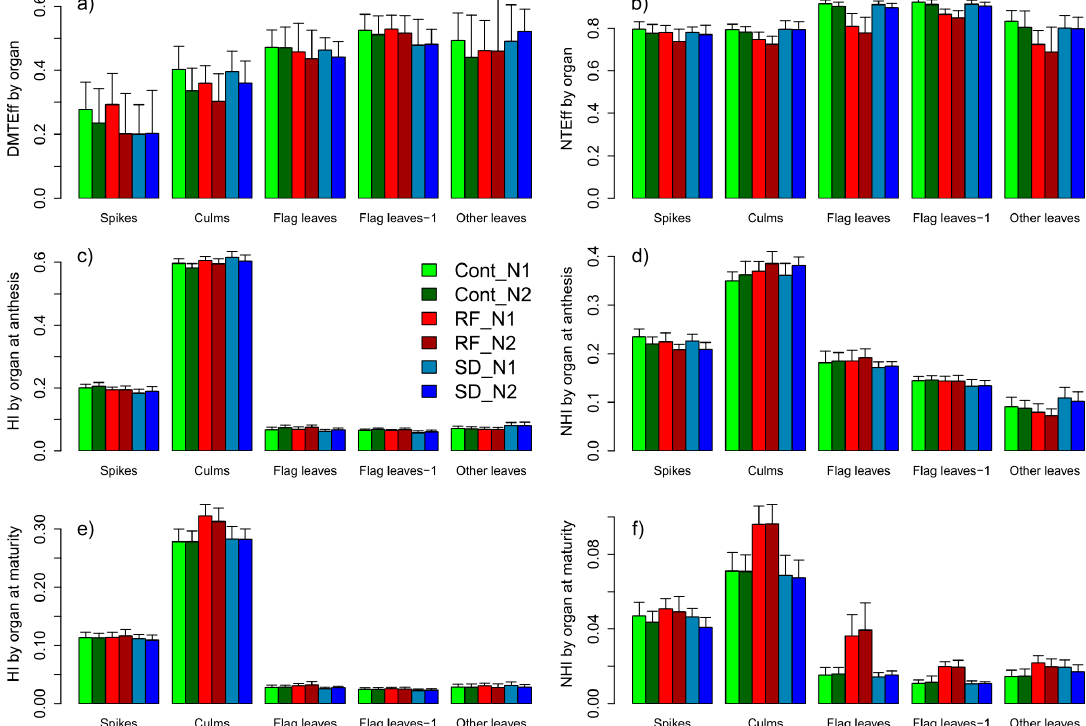
Figure 8. Reaction in the apparent translocation efficiency of dry matter (DMTEff, ( a )) and nitrogen (NTEff, ( b )) as well as in the proportional organ-level allocation of DM (partial harvest index HI, ( c, e )) and nitrogen (partial harvest index NHI, ( d, f )), both at anthesis and maturity, by vegetative plant organs and main plot (colors) and N (color intensity) treatments. Error bars are one-sided standard deviations. The ANOVA treatment effects are reported in Supplementary Table 1.